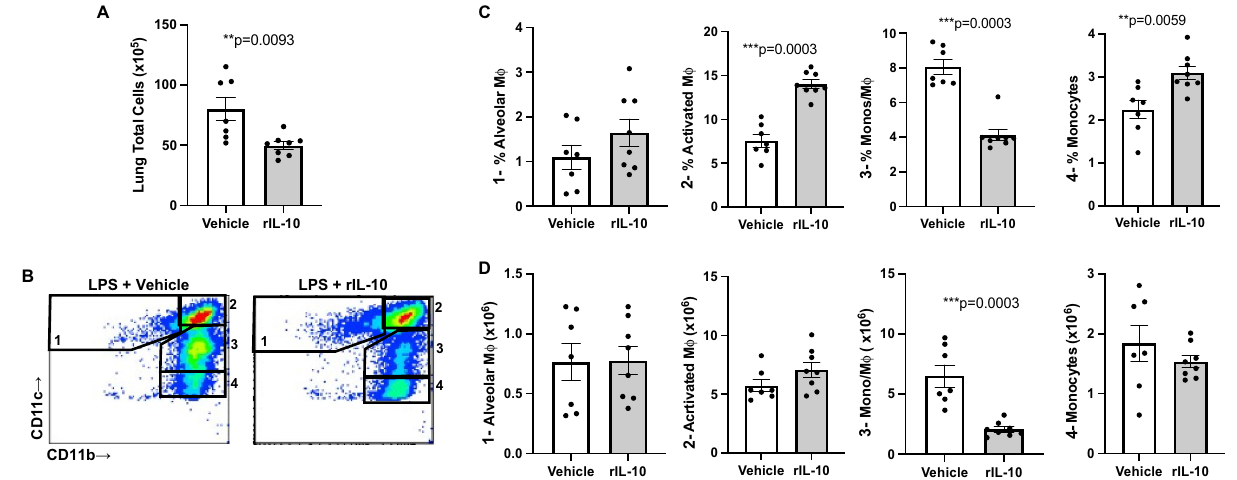
Figure 4. Instilled rIL10 treatment following a one-time LPS exposure modulates specific lung monocyte/ macrophage populations. ( A ) Scatter plot depicts mean with SE bars of total lung cells of vehicle vs. rIL-10 treatment groups post-LPS (10 μg) exposure. ( B ) Representative image of gates for lung macrophage/monocyte subpopulations between treatment groups: 1: Alveolar macrophages CD11c + CD11b lo , 2: Activated macrophages CD11c + CD11b hi , 3: Transitioning monocyte/macrophages CD11ci nt CD11b hi , 4: Monocytes CD11b hi CD11c - after exclusion debris, doublets, dead cells, CD45 - cells, and neutrophils (Supplemental Fig. 1). Percentage of monocyte/macrophage subpopulations from live CD45 + lung cells depicted by scatter plot graphs ( C ). This percentage then multiplied by total lung cells enumerated to denote number of these subpopulations ( D ). N = 7 (vehicle) and N = 8 (rIL-10) mice/group from 2 experimental runs. Statistical significance denoted by asterisks (**p < 0.01, ***p < 0.001).